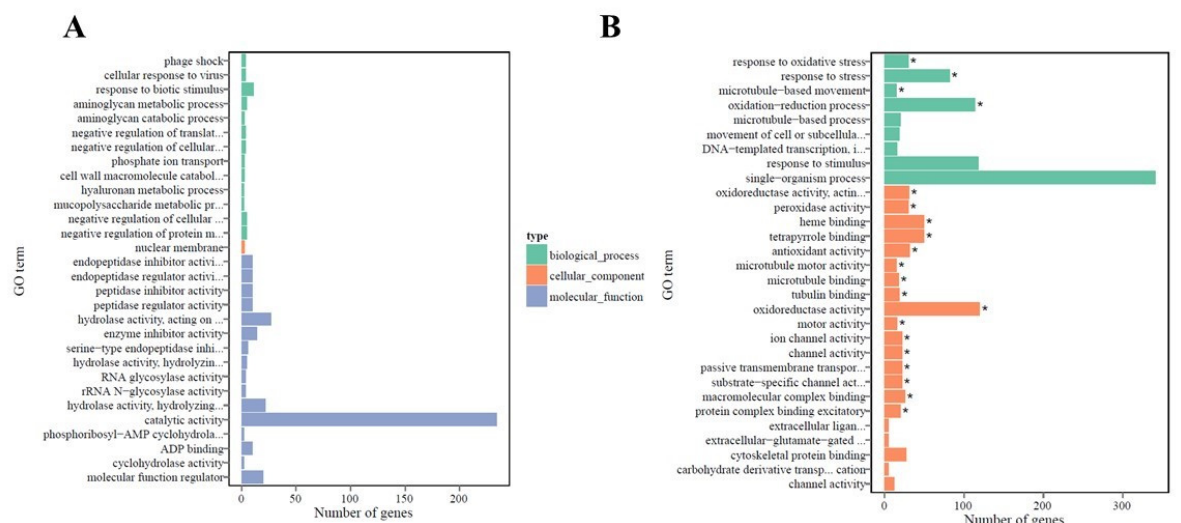
Figure 4. GO enrichment bar chart of DEGs: Gene Ontology (GO) of ( A ) upregulated and ( B ) downregulated differentially expressed genes (DEGs) in PI 175311 root tissue. The y-axis represents the enriched GO term, x-axis represents the number of DEGs enriched in the listed term. Colors represent different GO types: biological process, cellular component and molecular function. * GO with corrected p -value < 0.05 significantly enriched in DEGs.